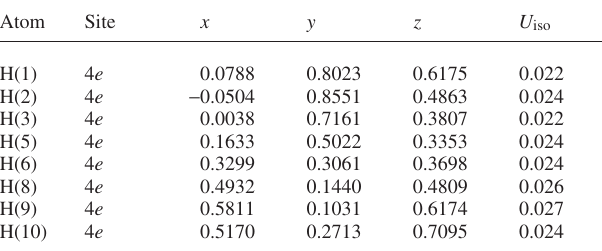
Table 2. Atomic coordinates and displacement parameters (in Å 2 )